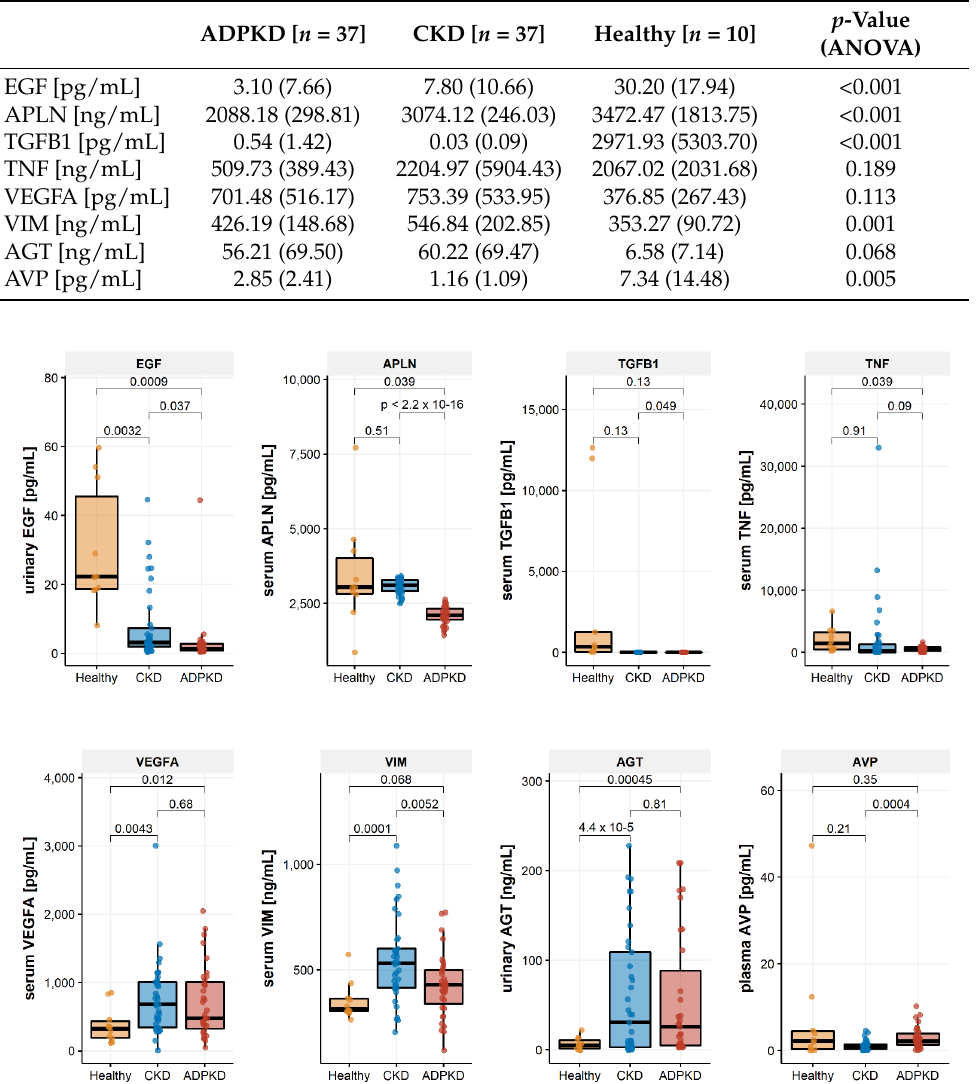
Table 3. Average marker concentrations plus standard deviations are presented along with the p -values of ANOVA test statistics.